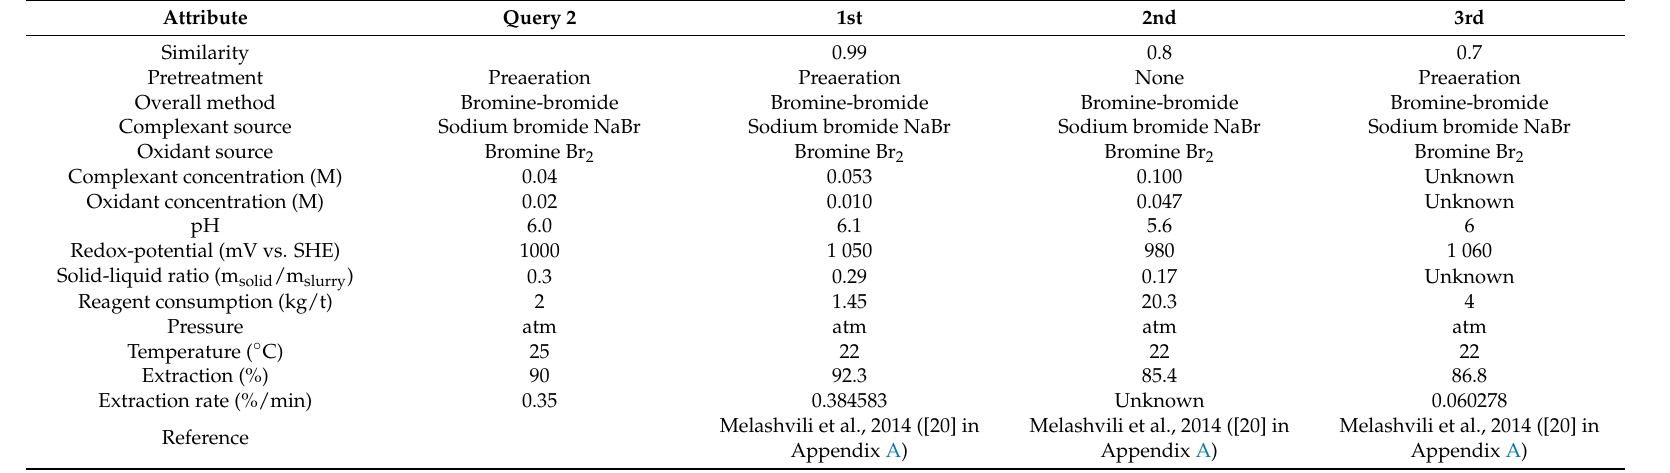
Table 6. Query 2 (Similar Articles) and all the retrieved articles according to similarity.